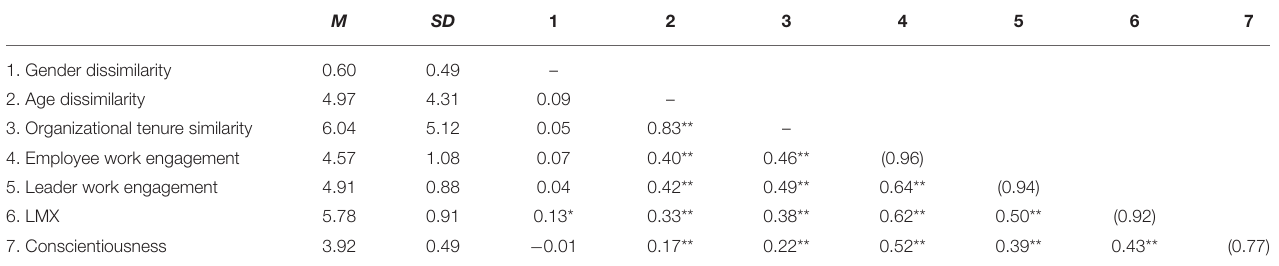
TABLE 1 | Mean, deviations, and correlations for all variables.